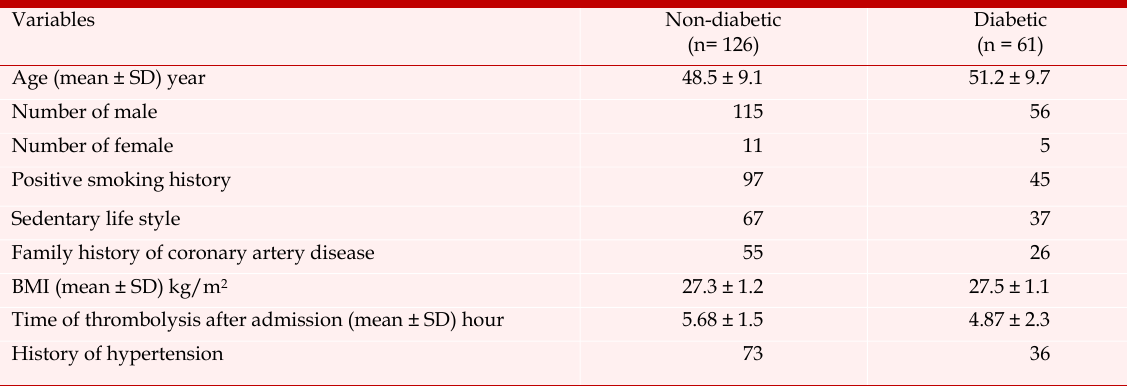
Baseline characteristics of non-diabetic and diabetic myocardial infarction